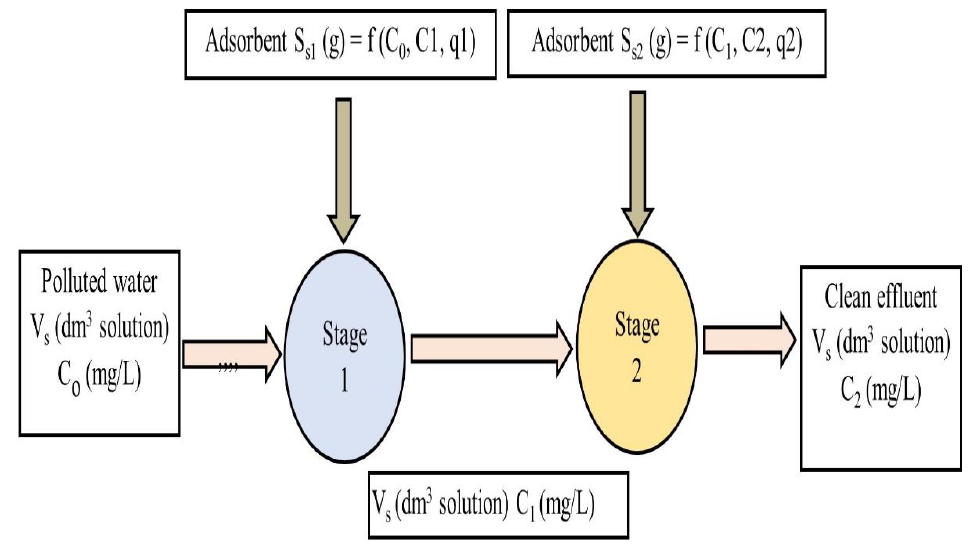
Figure 2. Schematic figure of a two-stage system.